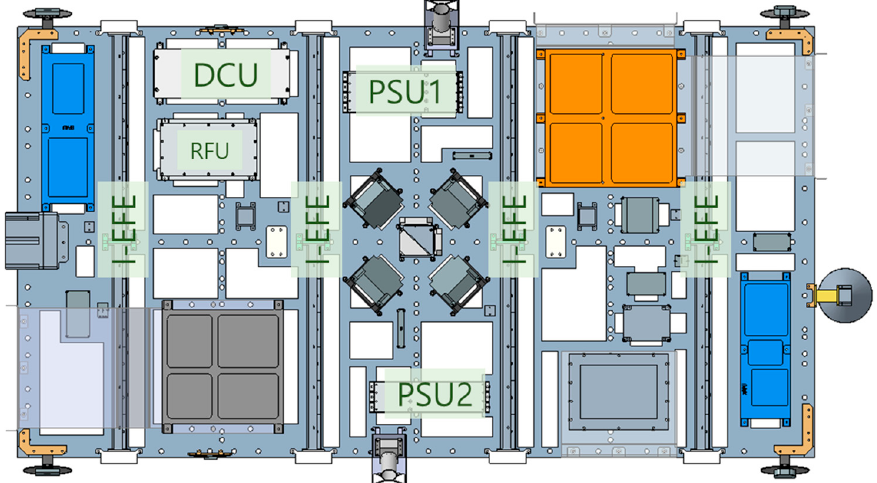
Figure 9. Internal layout of the S-STEP satellite units.